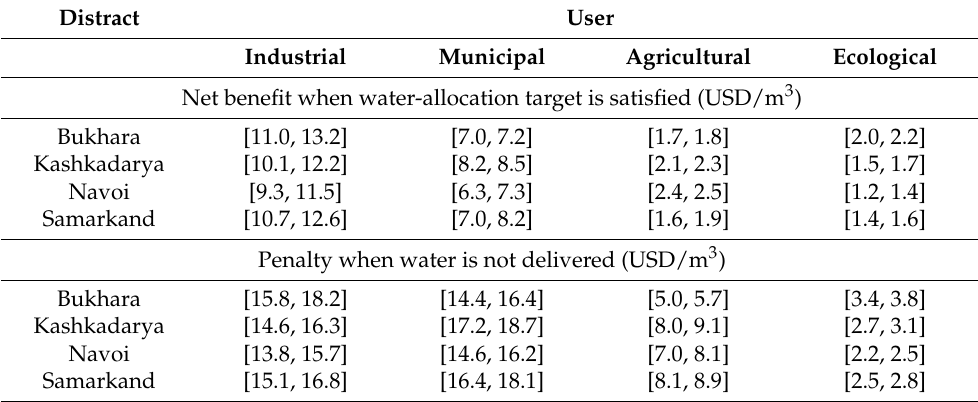
Table 4. Economic parameters used in the optimization model (USD/m 3